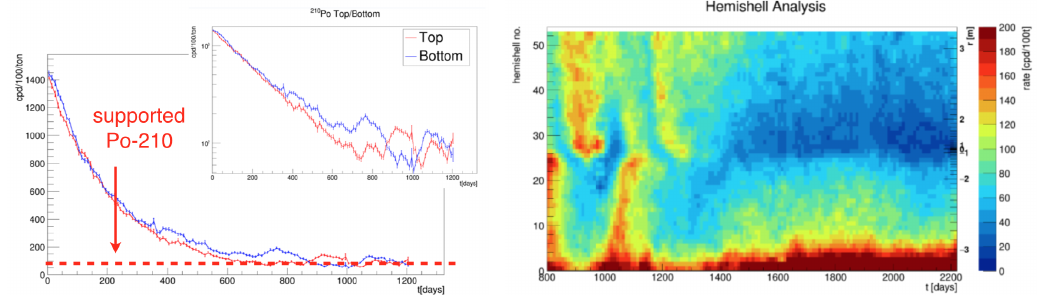
Figure 7: Left: The 210 Po activity in the inner part of the Borexino scintillator volume versus time for the Phase II dataset. The data is divided between top and bottom half of the volume. It shows deviations from a pure exponential decay with the 210 Po half life (138 days), a behavior consistent with ’dirtier’ scintillator from outside the fiducial volume entering and leaving it as a result of convective motions. Right: the effectiveness of thermally insulating the Borexino tank is evident from the ensuing layering of the 210 Po activity inside the fiducial